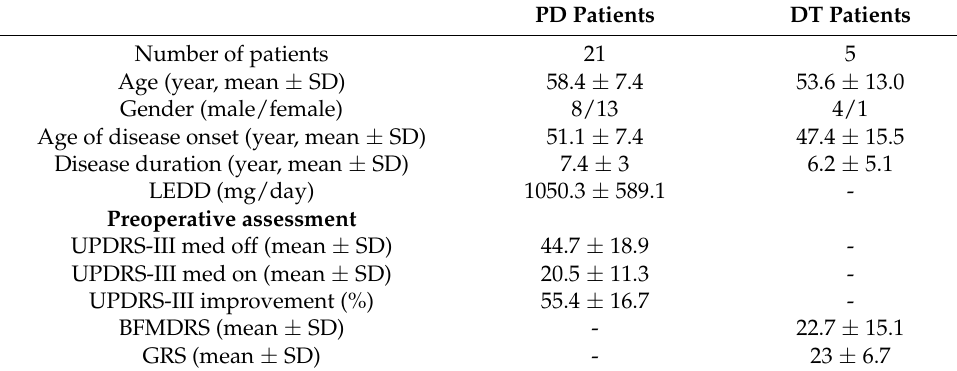
Table 1. Patient baseline characteristics.